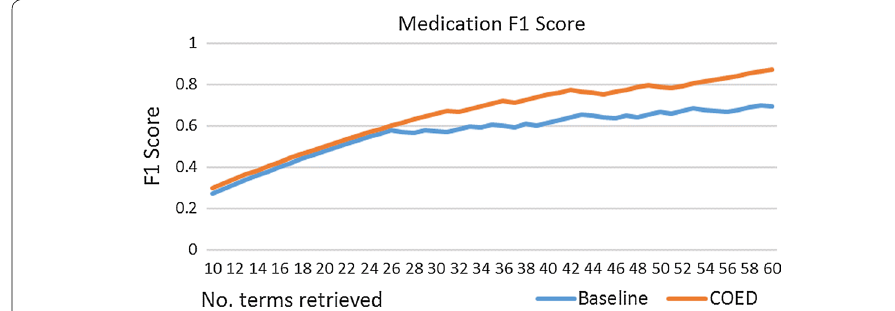
Fig. 15 Comparison of medication F1 score for baseline and COED methodologies